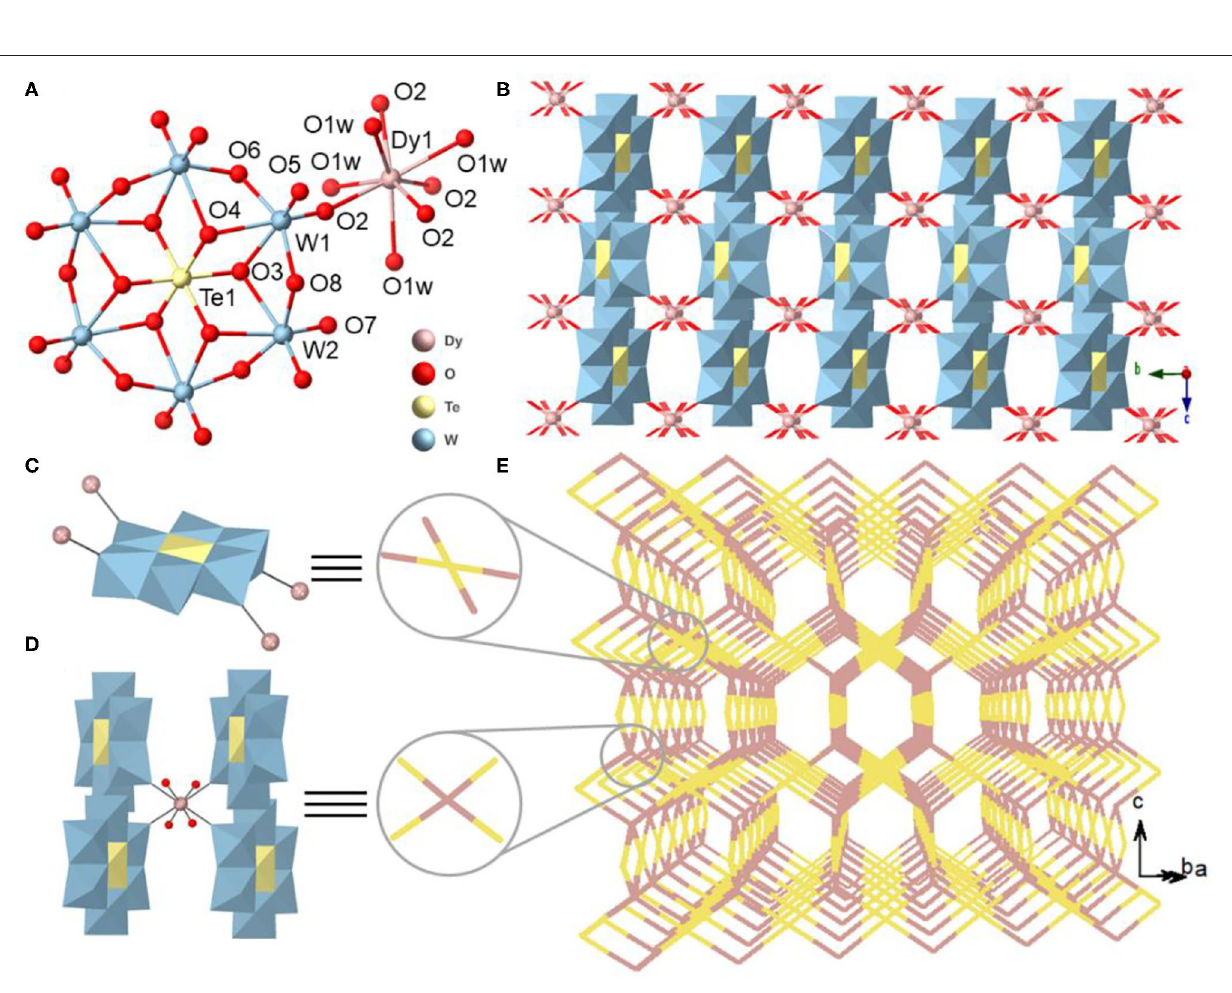
Frontiers in Chemistry |